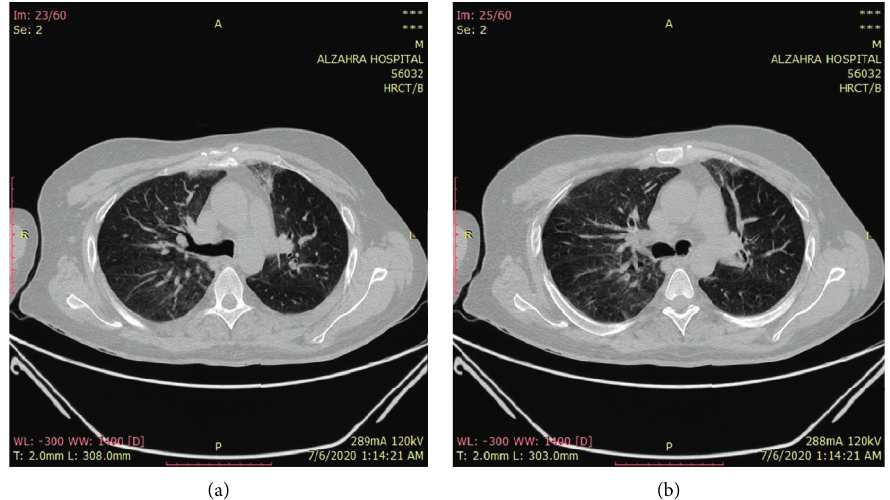
Figure 2: Bilateral and peripheral ground-glass pulmonary opacities.